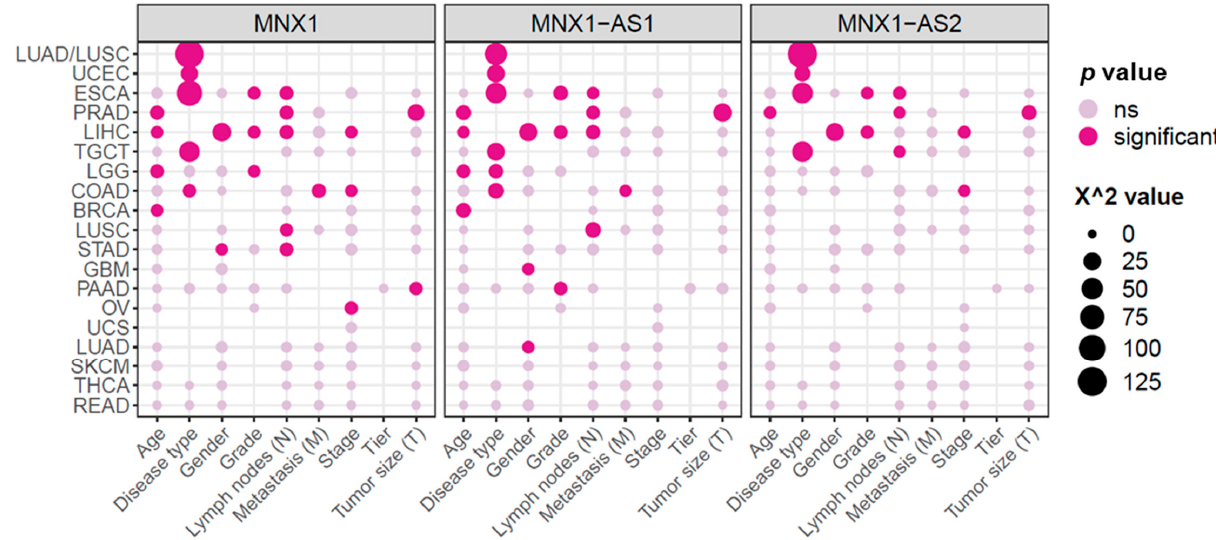
Figure 4. Summary of correlations between MNX1, MNX1-AS1, and MNX1-AS2 expressions and clinicopathological features. Each dot represents the value of Chi-square correlation expressed in X 2 value, as well as the statistical significance in pink (at a threshold of p value < 0.05). Detailed sample information on statistically significant features is reported in Supplementary Table